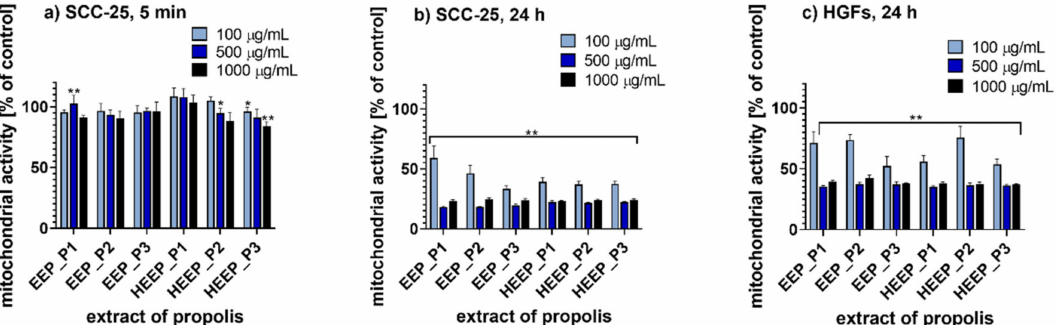
Figure 2. MTT assay results for: ( a ) tongue cancer cells (SCC-25) incubated for 5 min with propolis extracts; ( b ) tongue cancer cells (SCC-25) incubated for 24 h with propolis extracts; ( c ) human gingival fibroblasts (HGFs) incubated for 24 h with propolis extracts; * p < 0.05, ** p < 0.005; P1—propolis from